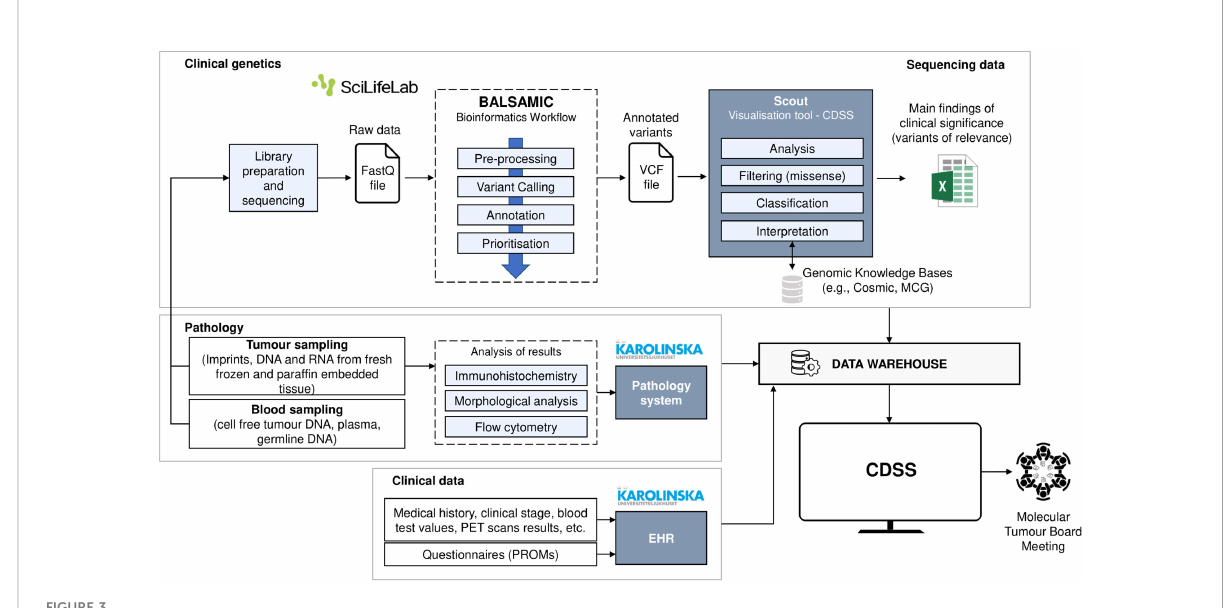
FIGURE 3 Future work fl ow for MTB meetings in the BioLymph